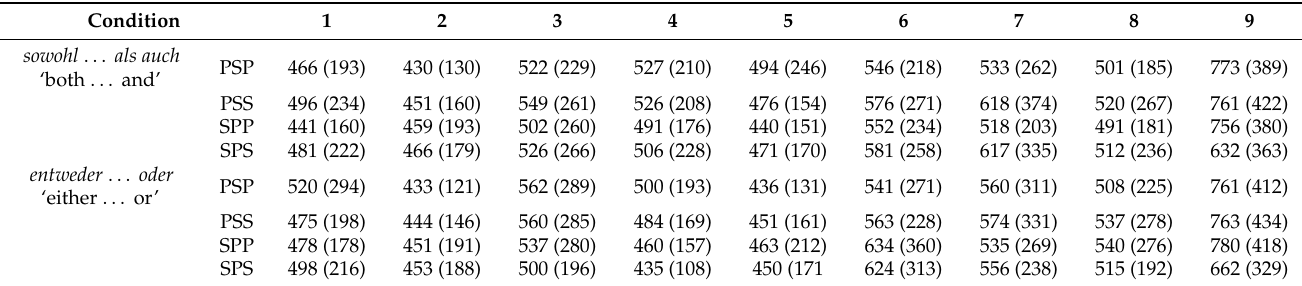
Table 9. Mean reading times in milliseconds (SDs in parentheses) per word and condition for both conjunctions, Experi- ment 3.